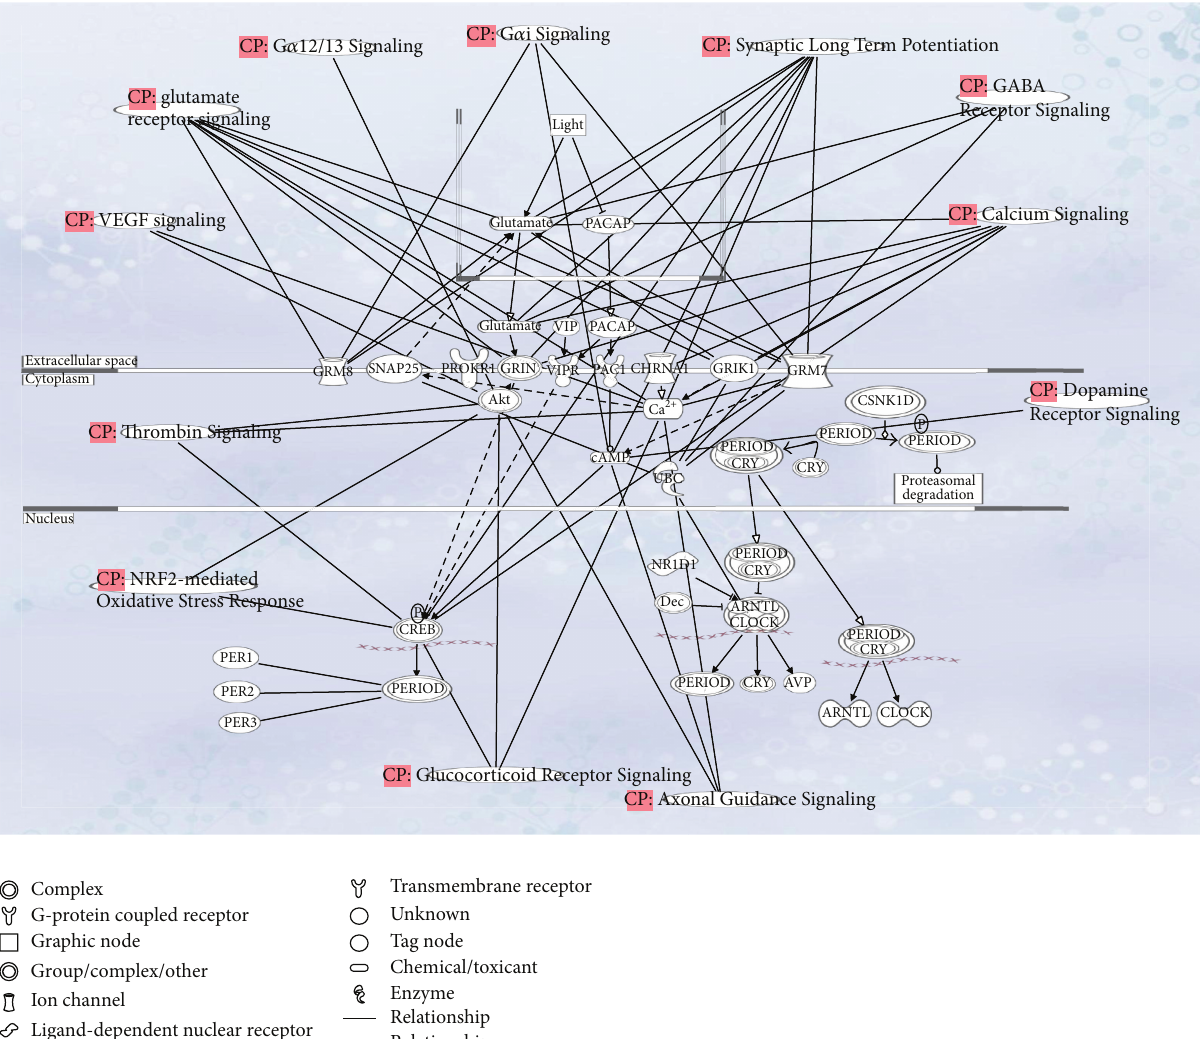
Figure 5: Represented is the gene network “Circadian Rhythm Signaling” showing interconnected neurotransmitter signaling